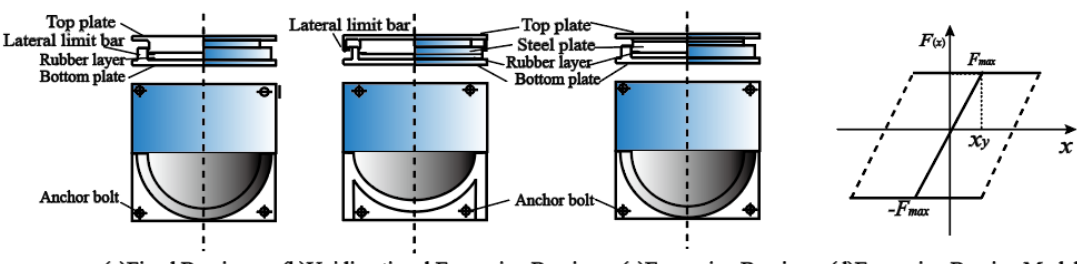
Figure 5. Composition and model of bearing.